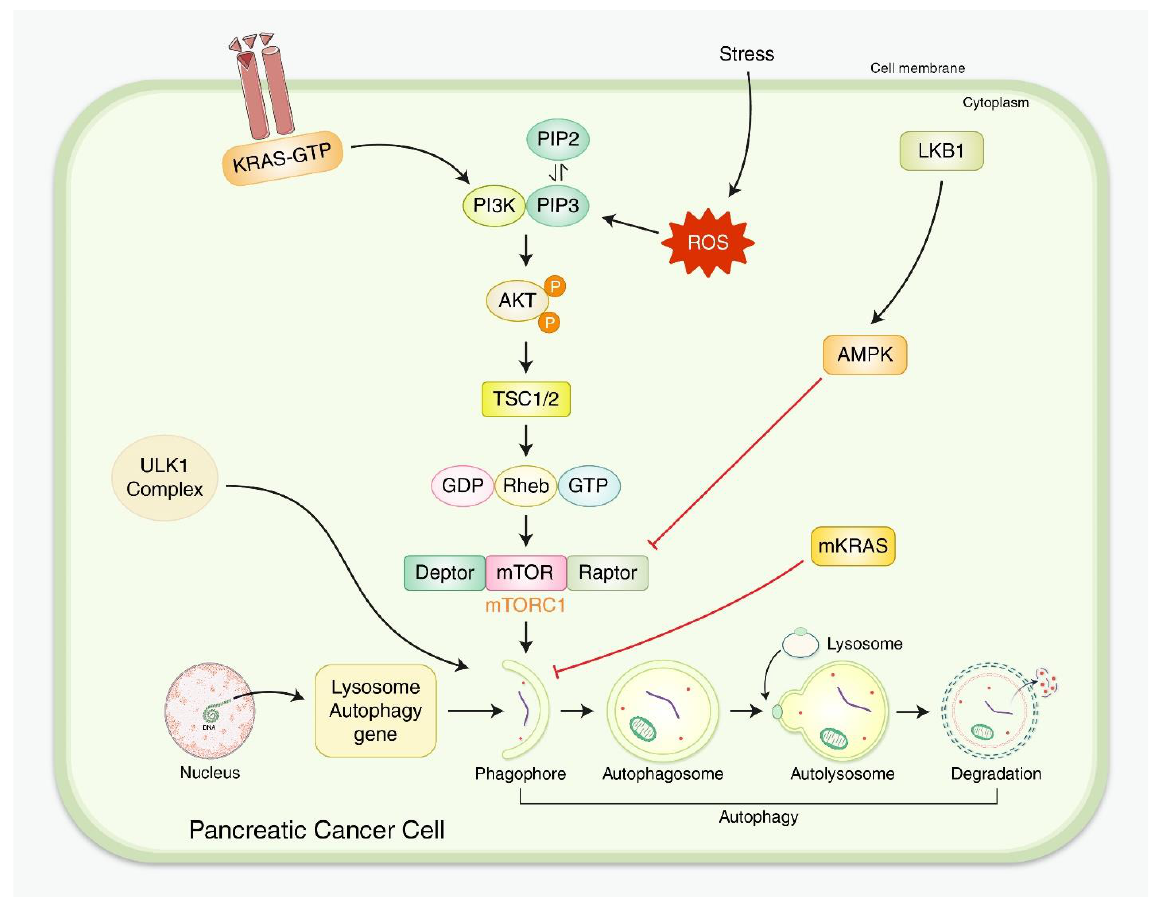
Figure 3. The molecular pathways involved in regulating PC metabolism through autophagy.